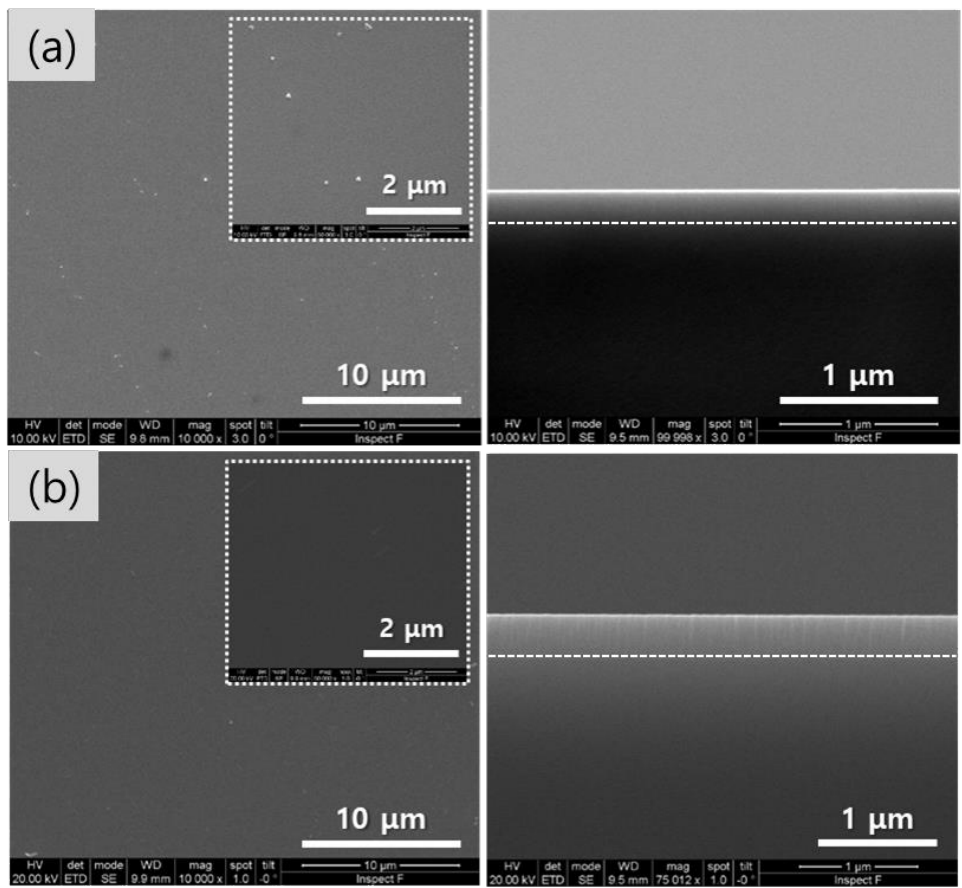
Figure 5. Surface morphologies and cross-sectional images of KTN thin films deposited on SrTiO 3 substrate for ( a ) 3 h and ( b ) 6 h.